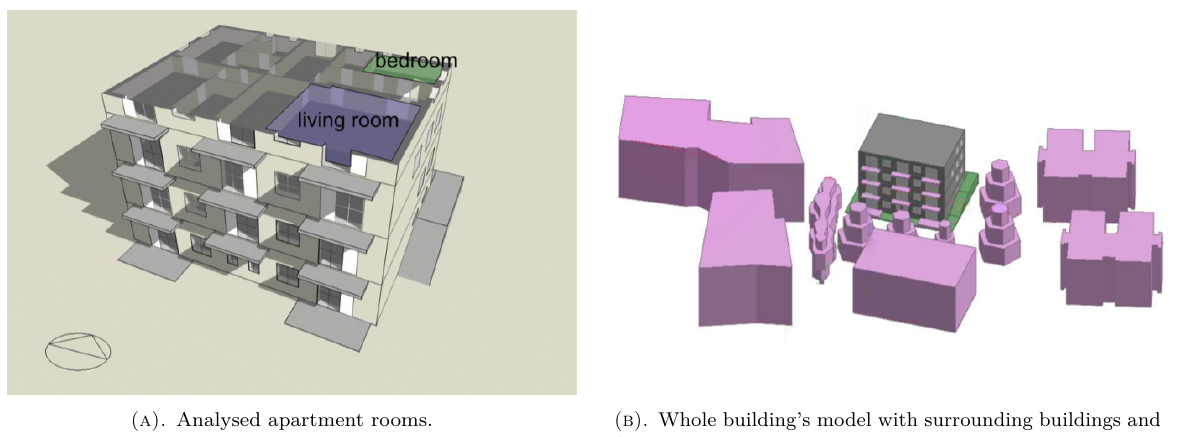
Figure 3. 3D model of the analysed building.